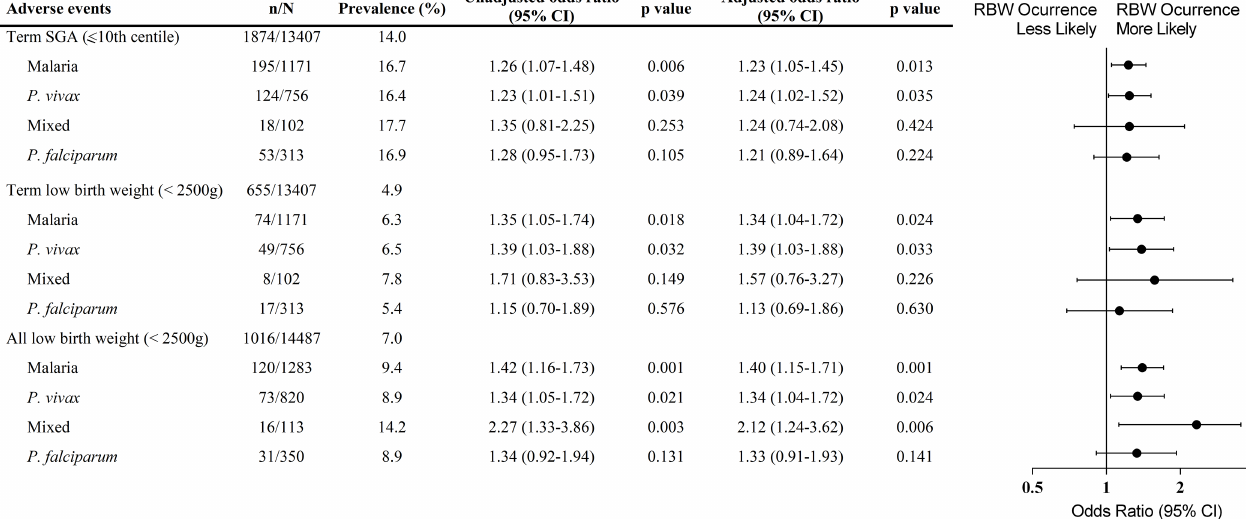
PLOS ONE | https://doi.org/10.1371/journal.pone.0199415 June 21,